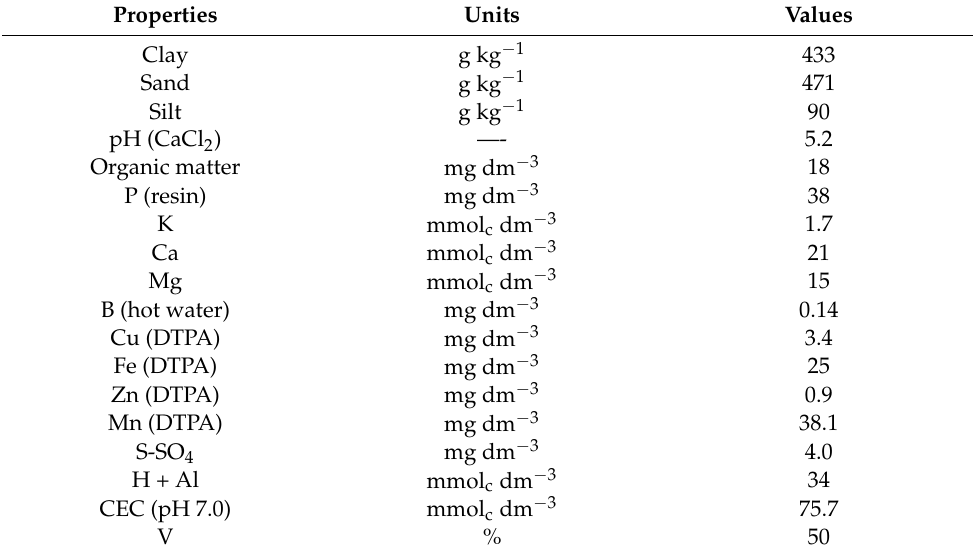
Table 1. Analyzed results of soil sample (0–0.20 m) from experimental site before